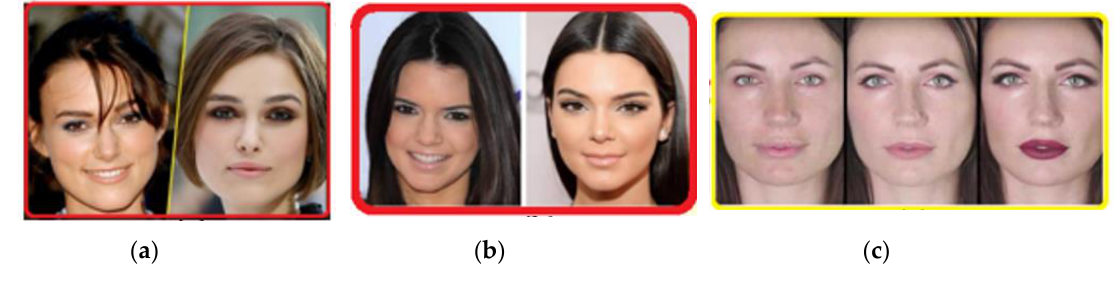
Figure 35. ( a , b ) Plastic surgery. ( c ) Facial cosmetics.